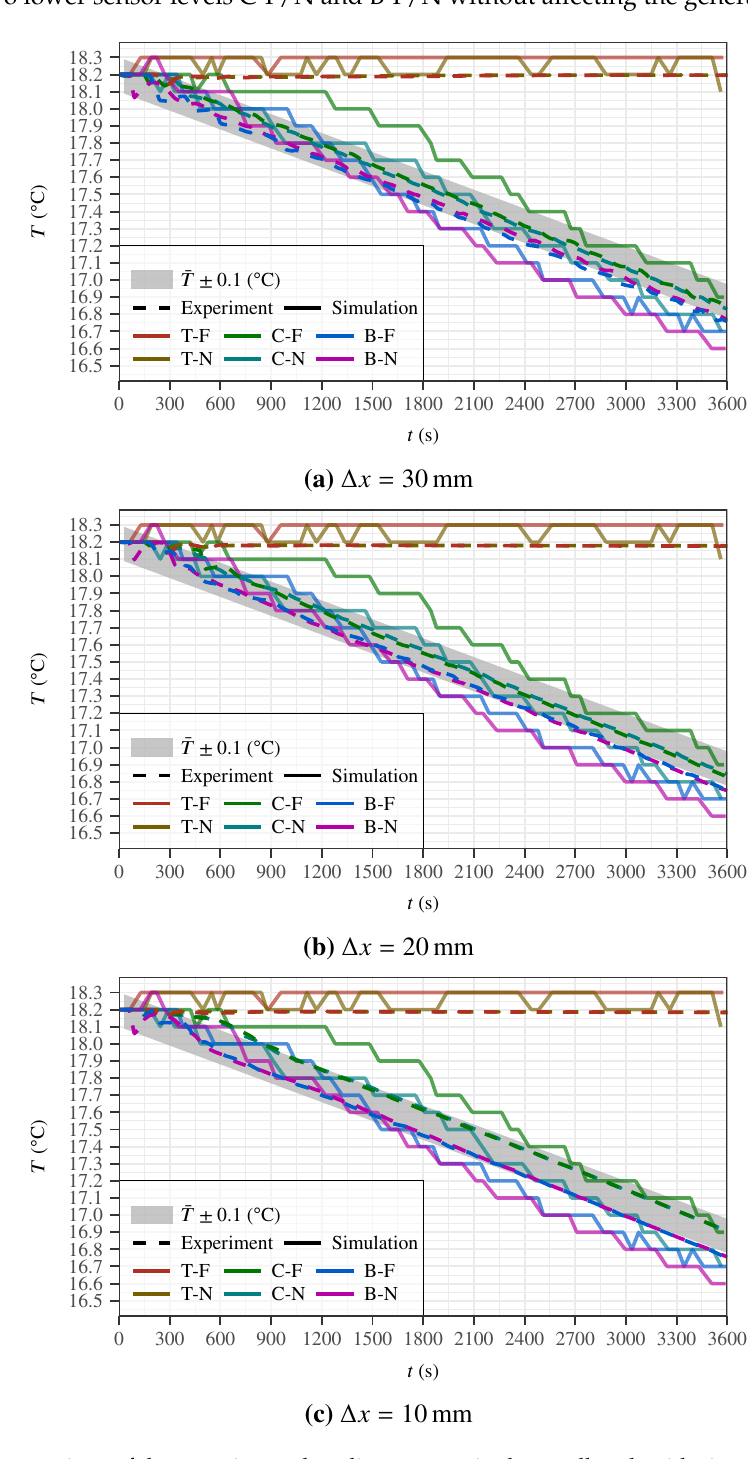
Figure 6. Comparison of the experimental cooling process in the small tank with simulation data on three different grid resolutions ( ∆ x ), 30mm ( a ); 20mm ( b ) and 10mm ( c ), referring to six different sensor locations inside the